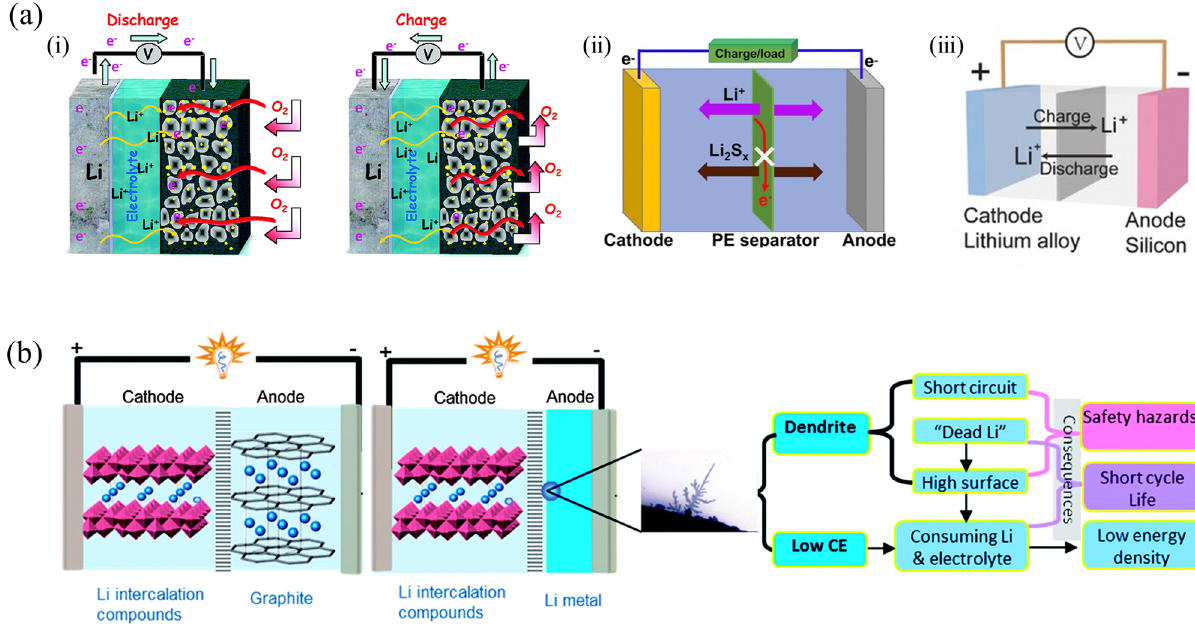
Figure 1: ( a ) Representative lithium - ion battery structure diagrams of ( i ) lithium – air battery, reprinted with permission from [ 11 ] , ( ii ) lithium – sulfur battery, reprinted with permission from ref. [ 12 ] , and ( iii ) lithium – silicon battery, reprinted with permission from ref. [ 3 ] ; ( b ) schematic diagrams of lithium metal batteries and the typical morphology of lithium dendrites as well as the main problems, reprinted with permission from ref. [ 7 ]